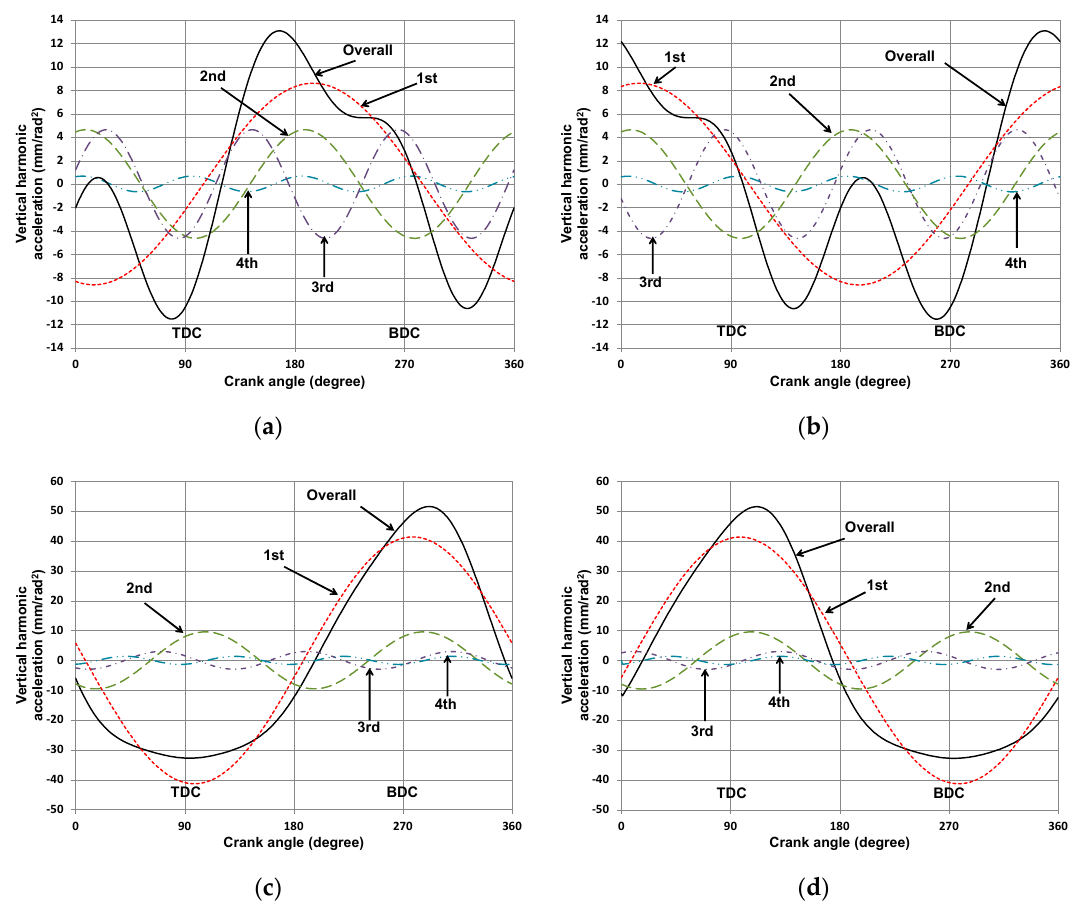
Figure 5. Vertical harmonic acceleration components at joints P 2 and P 5 of the initially designed Stephenson III mechanism: ( a ) Joint P 2 in Cylinder 1; ( b ) Joint P 2 in Cylinder 2; ( c ) Joint P 5 in Cylinder 1; and ( d ) Joint P 5 in Cylinder 2.